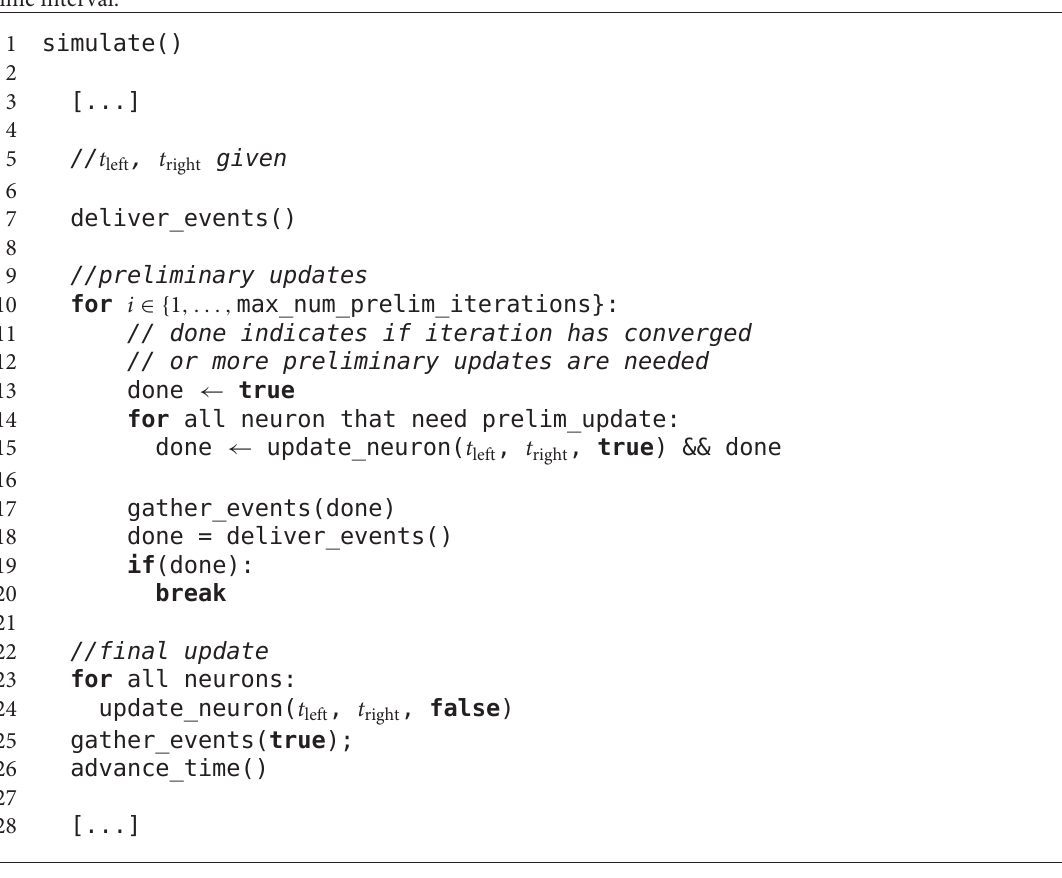
Algorithm 1 | Pseudo code of the simulate function in the scheduler: Lines 9-20 show the additional code due to the new preliminary updates. An additional boolean value passed to the update function of a neuron distinguishes a preliminary